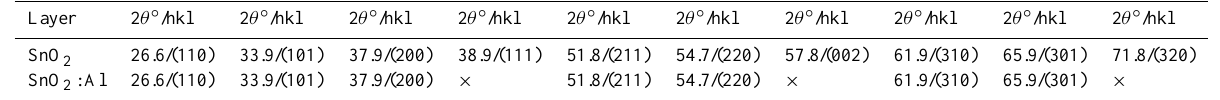
Table 2. XRD-obtained peaks and orientations, where hkl are the Miller indices. The cells with × indicate NO peak observed at given 2 θ . Layer